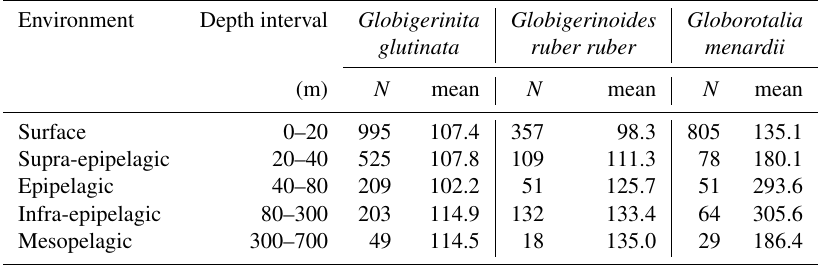
Table A2. Number of living specimens ( N ) and mean size (minor axis, in µm) of planktonic foraminifera per species and depth intervals.